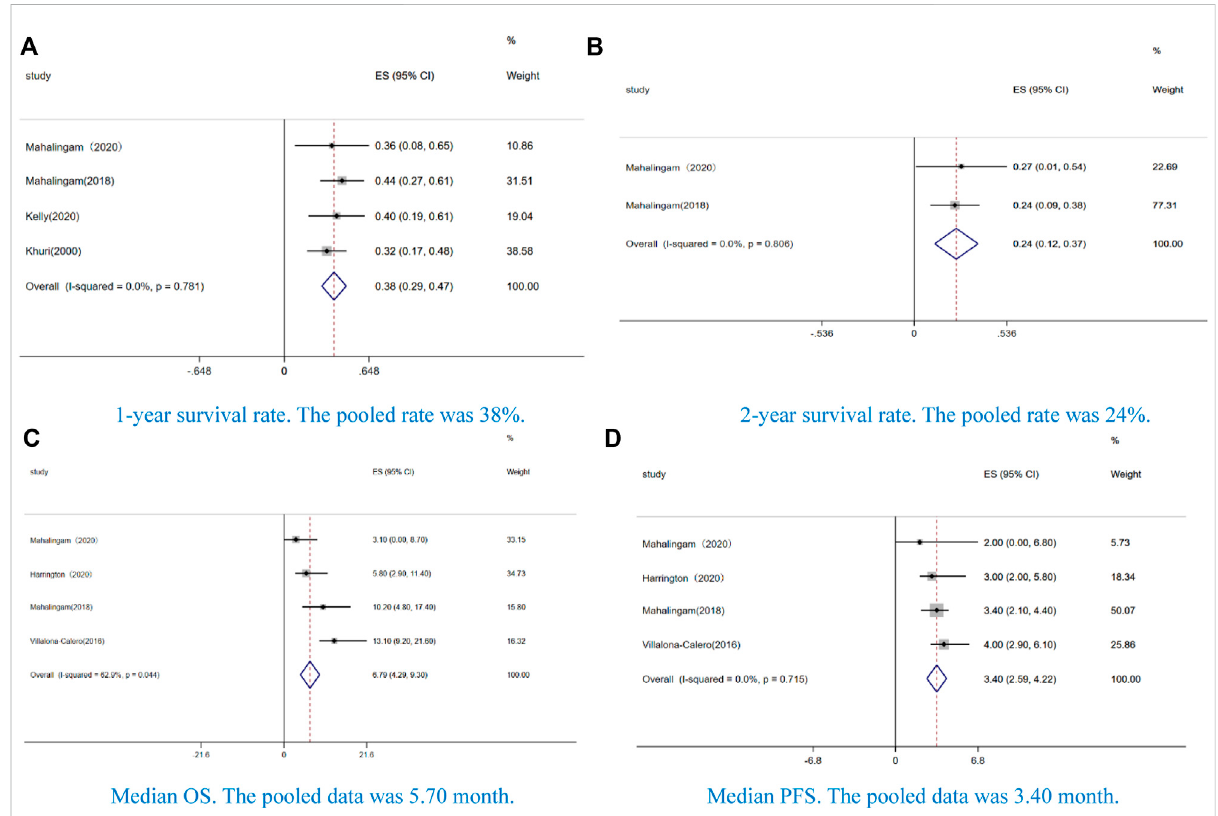
FIGURE 3 Forest plot of the pooled data of survival, including (A) 1-year survival rate, (B) 2-year survival rate, (C) median overall survival (OS), and (D) median progression-free survival